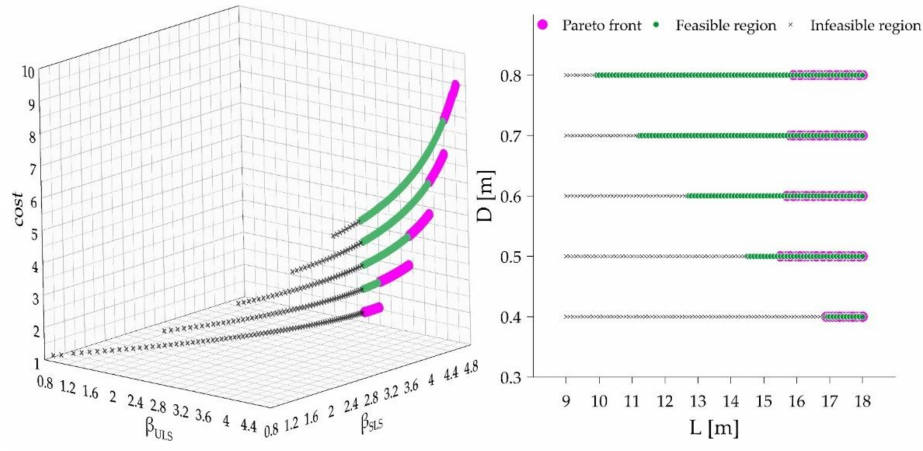
Figure 17. The Pareto front, along with the dominated and infeasible designs in objective space ( left ) and decision space ( right ).